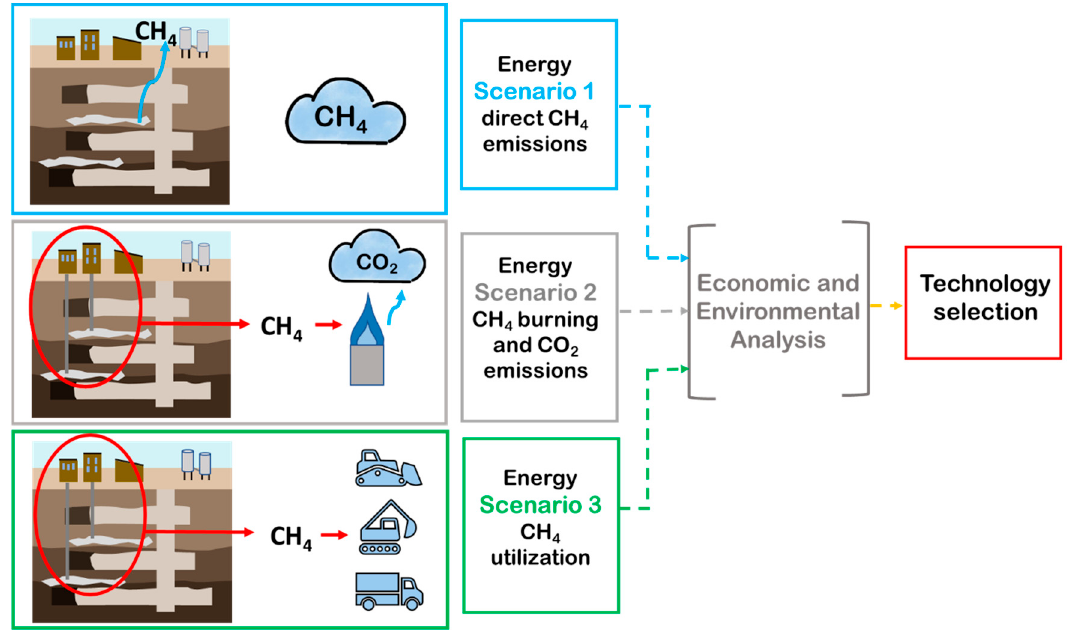
Figure 2. Outline of the methodology applied in this study and the scenario definition.